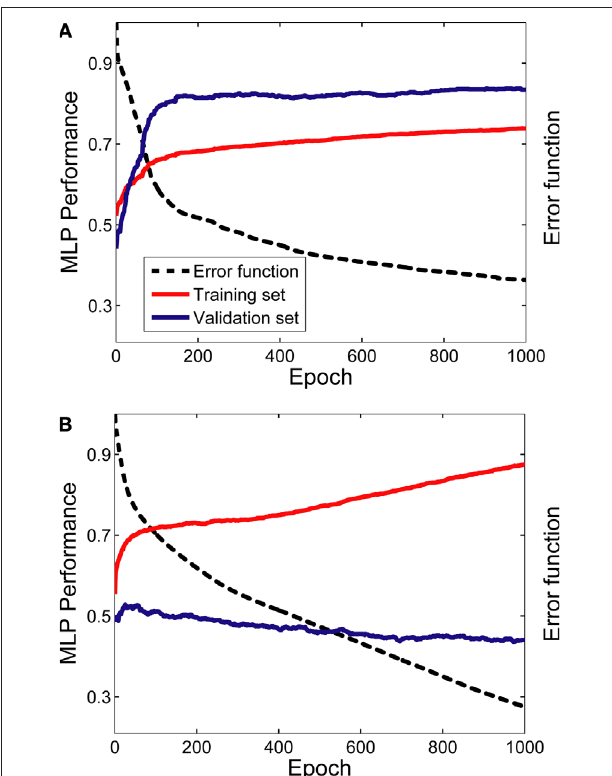
FIGURE 4 | Learning examples from two neurons. Panel (A) was generated from the neuron whose activity most reliably refl ected the monkey’s decisions (in terms of the MLP’s performance on the validation dataset); whereas the data in panel (B) were generated from the neuron whose activity least reliably refl ected the monkey’s decisions. The graphs in both panels show the average training (red data) and validation (blue data) history; these average values were calculated from the 50 individual training histories that were generated from each of the 50 MLPs constructed for each neuron. The error function (dotted black line) is also shown as a function of training epoch; the error function is